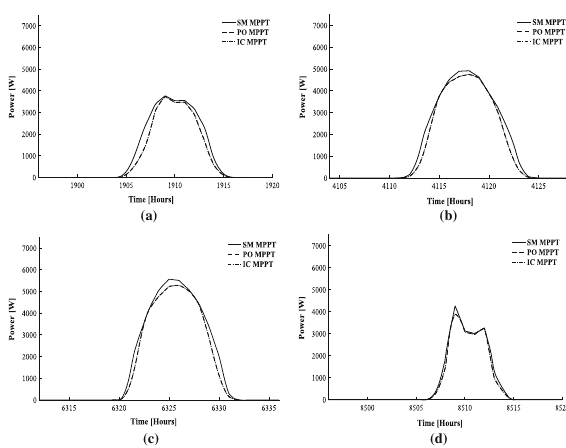
Fig. 9 Daily generated power using different MPPT techniques on the Poly-Si PV array MSX60 for a March 21, b